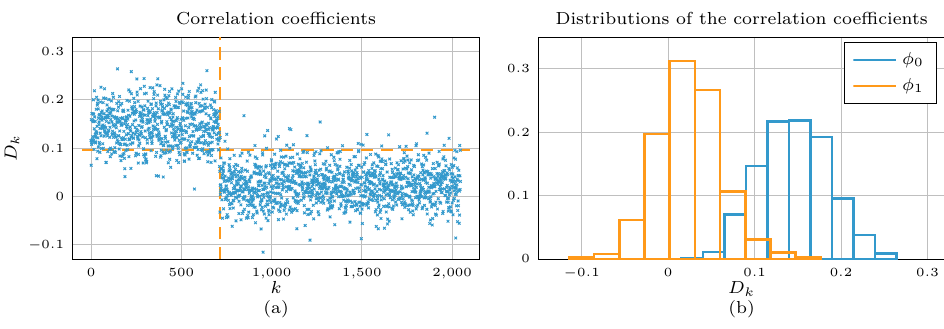
Figure 1: (a) The distinguisher values (correlation coefficients) of the key bits chosen by an unsuccessful H-CPA attack. The vertical dashed line indicates an error occurred at step τ = 713, causing a change of distribution. The horizontal dashed line indicates the optimal threshold separating the distinguisher values before and after τ , as discussed in Section 6.3. (b) Two histograms representing the empirical distribution of the distinguisher before (blue) and after (orange) τ = 713: the two distributions are significantly